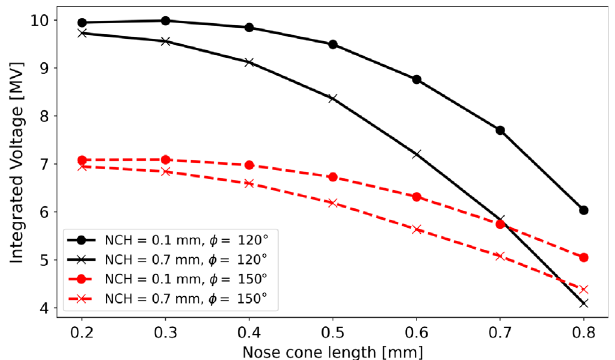
TABLE II. TWS single cell